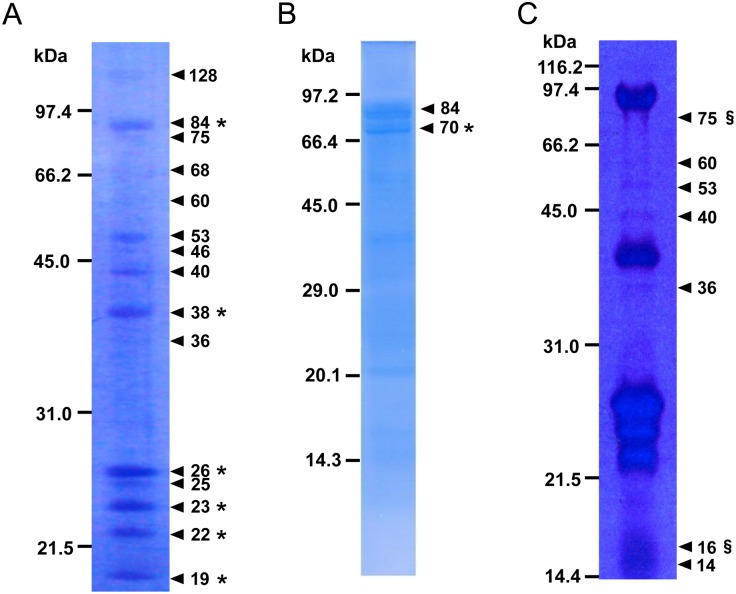
Proteins in watery saliva collected from 5% sucrose diet that N. cincticeps had fed on.
(A) Salivary proteins electroblotted onto a PVDF membrane after being subjected to SDS-PAGE (12.5% polyacrylamide gel) under reducing conditions and (B) SDS-PAGE (15% gel) under non-reducing/non-heating conditions. N-terminal sequences of protein bands marked with asterisks were determined using a gas-phase protein sequencer. (C) Salivary proteins separated on a gel after being subjected to SDS-PAGE (13% gel) under reducing conditions. Protein bands marked with section signs were identified using MS-MS analysis combined with our EST database.